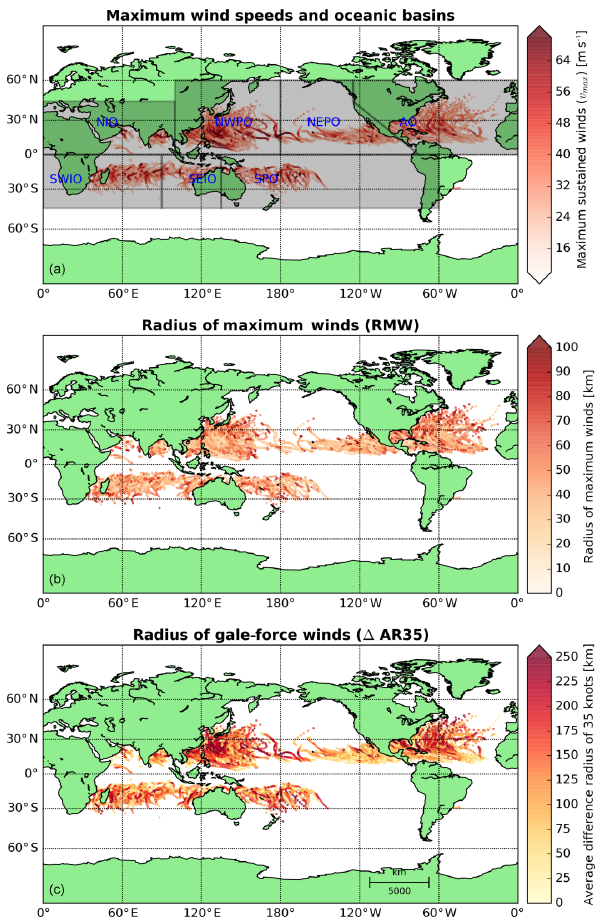
Figure 2. Observed maximum sustained wind speeds and defini- tion of the different ocean basins (a) . The observed radius of max- imum winds (b) and observed radius of gale-force winds (c) for all the